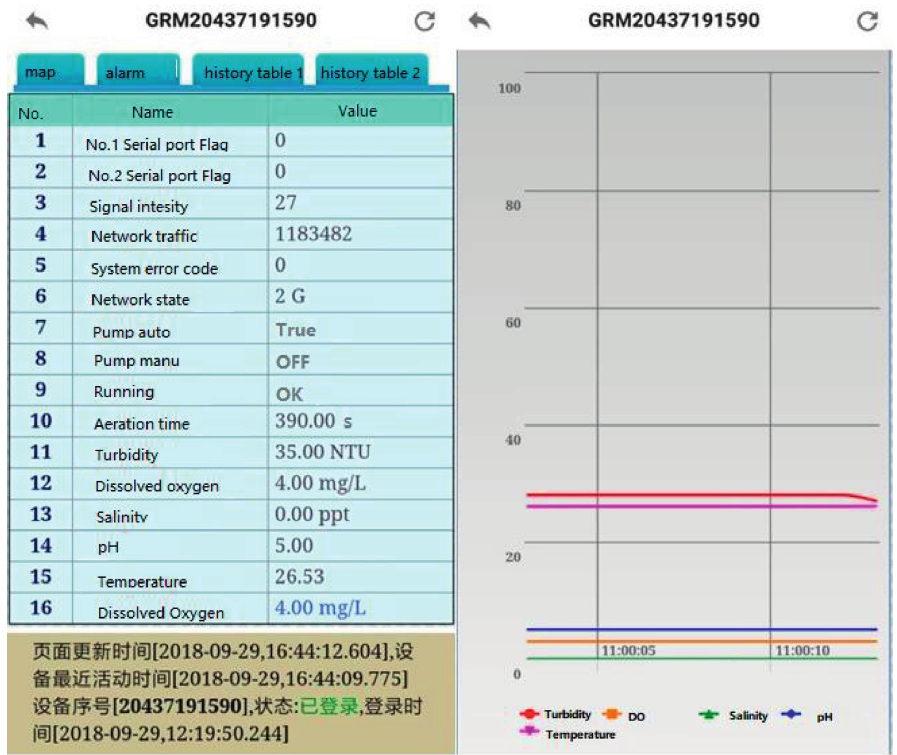
Figure 9: Control interface of